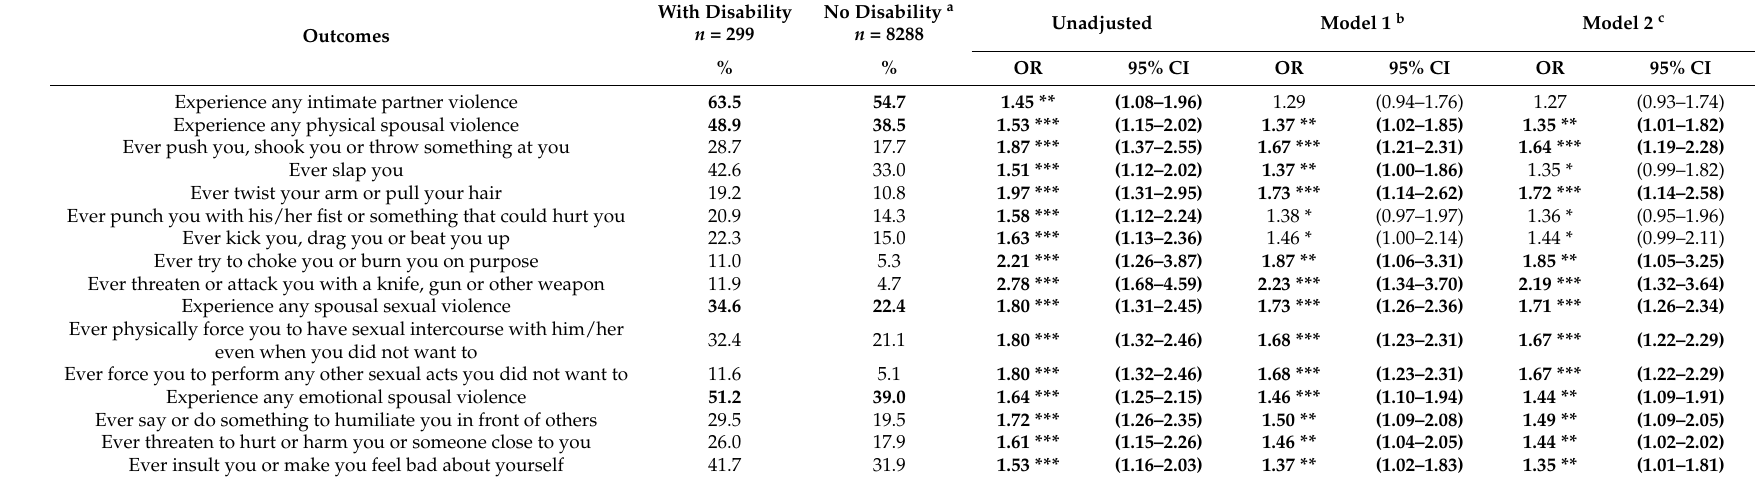
Table 2. Associations between disability status and experience of specific acts of violence among women with and without disabilities, aged 15–49, Uganda: percentages, unadjusted and adjusted odds